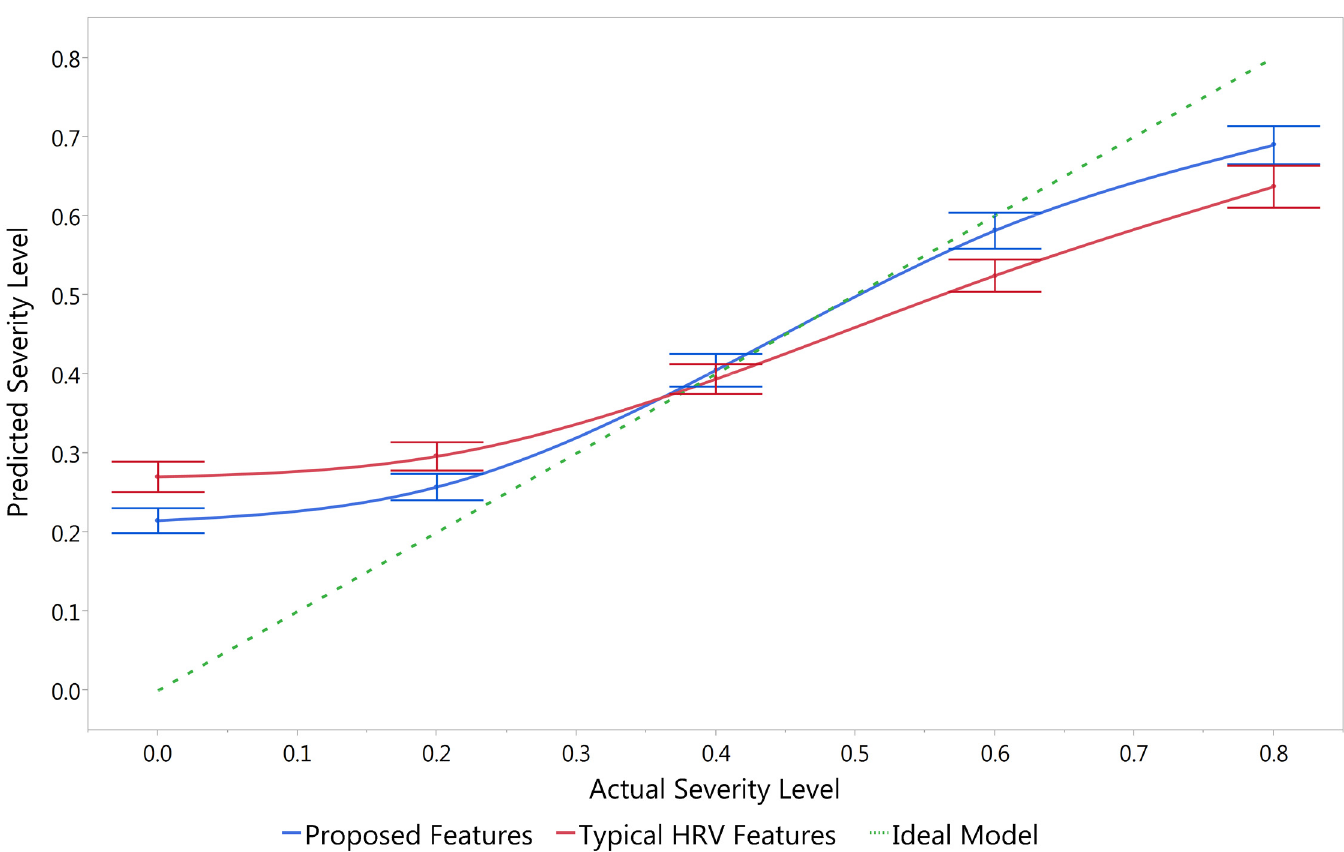
Fig 5. Predicted versus actual severity levels. The predicted severity levels are computed using multiple linear regression of the 10 selected features versus the typical HRV features. The bars indicate 95% confidence